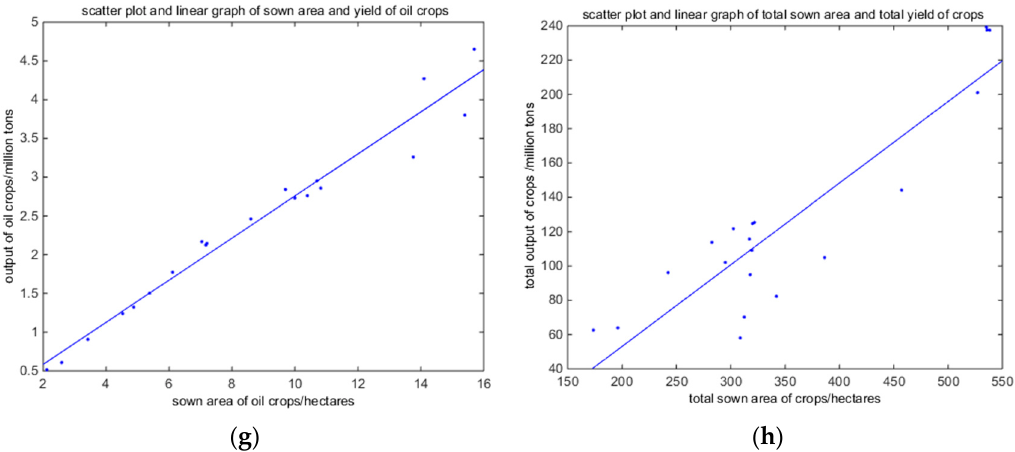
Figure 2. Graph showing the linear relationship between crop yield and sowing area with least squares analysis in Beijing: ( a ) Rice; ( b ) Wheat; ( c ) Maize; ( d ) Tuber; ( e ) Beans; ( f ) Cotton; ( g ) Peanuts; ( h ) Total grain.